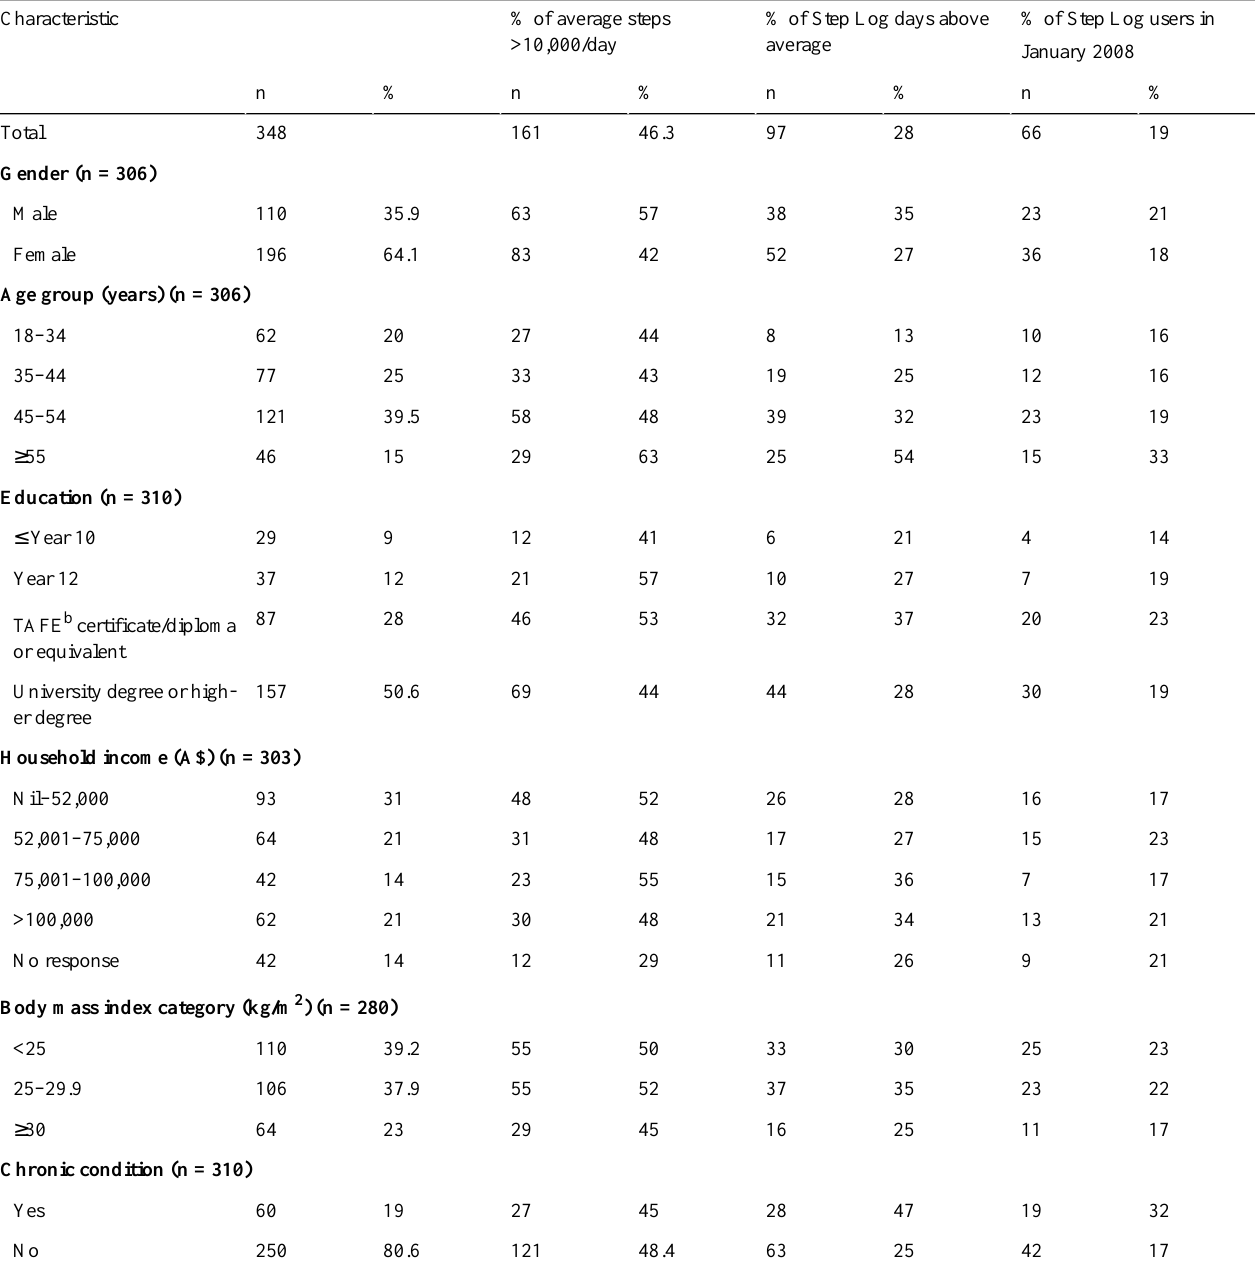
Table 1. Descriptive summary of participant characteristics by website engagement statisticsa